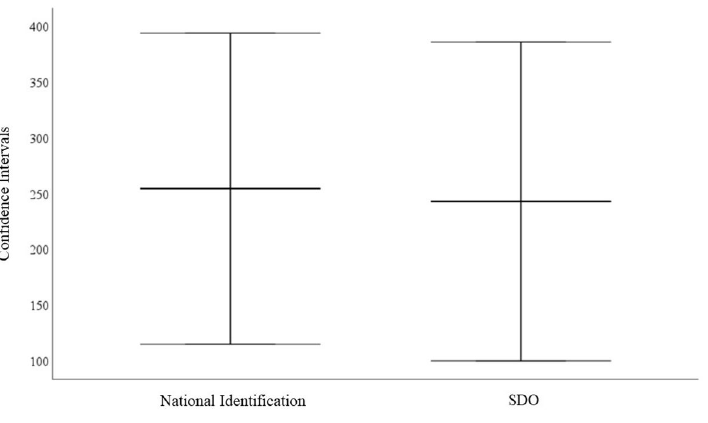
Social Psychological Bulletin | 2569-653X